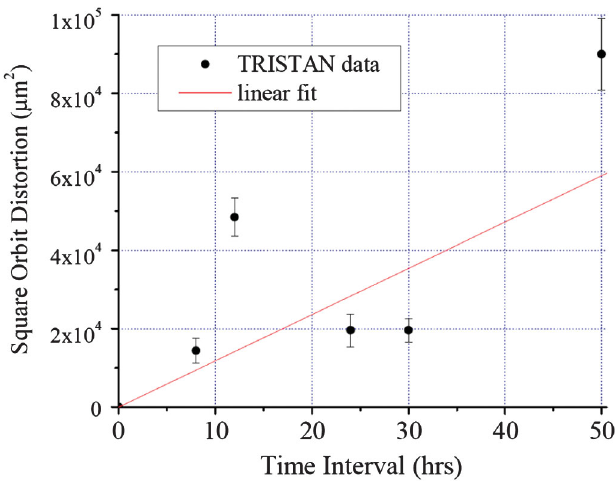
FIG. 4. (Color) Variance of the TRISTAN orbit variations [17].